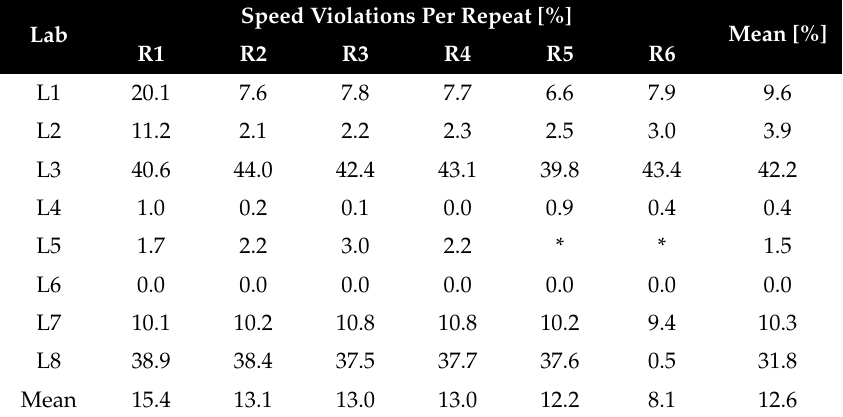
Table 3. Summary of speed violations for all six repetitions during T1 for all labs—the % values indicate the amount of time during the entire cycle that the dynamometer speed was outside the ± 2 km / h threshold. (*) denotes missing